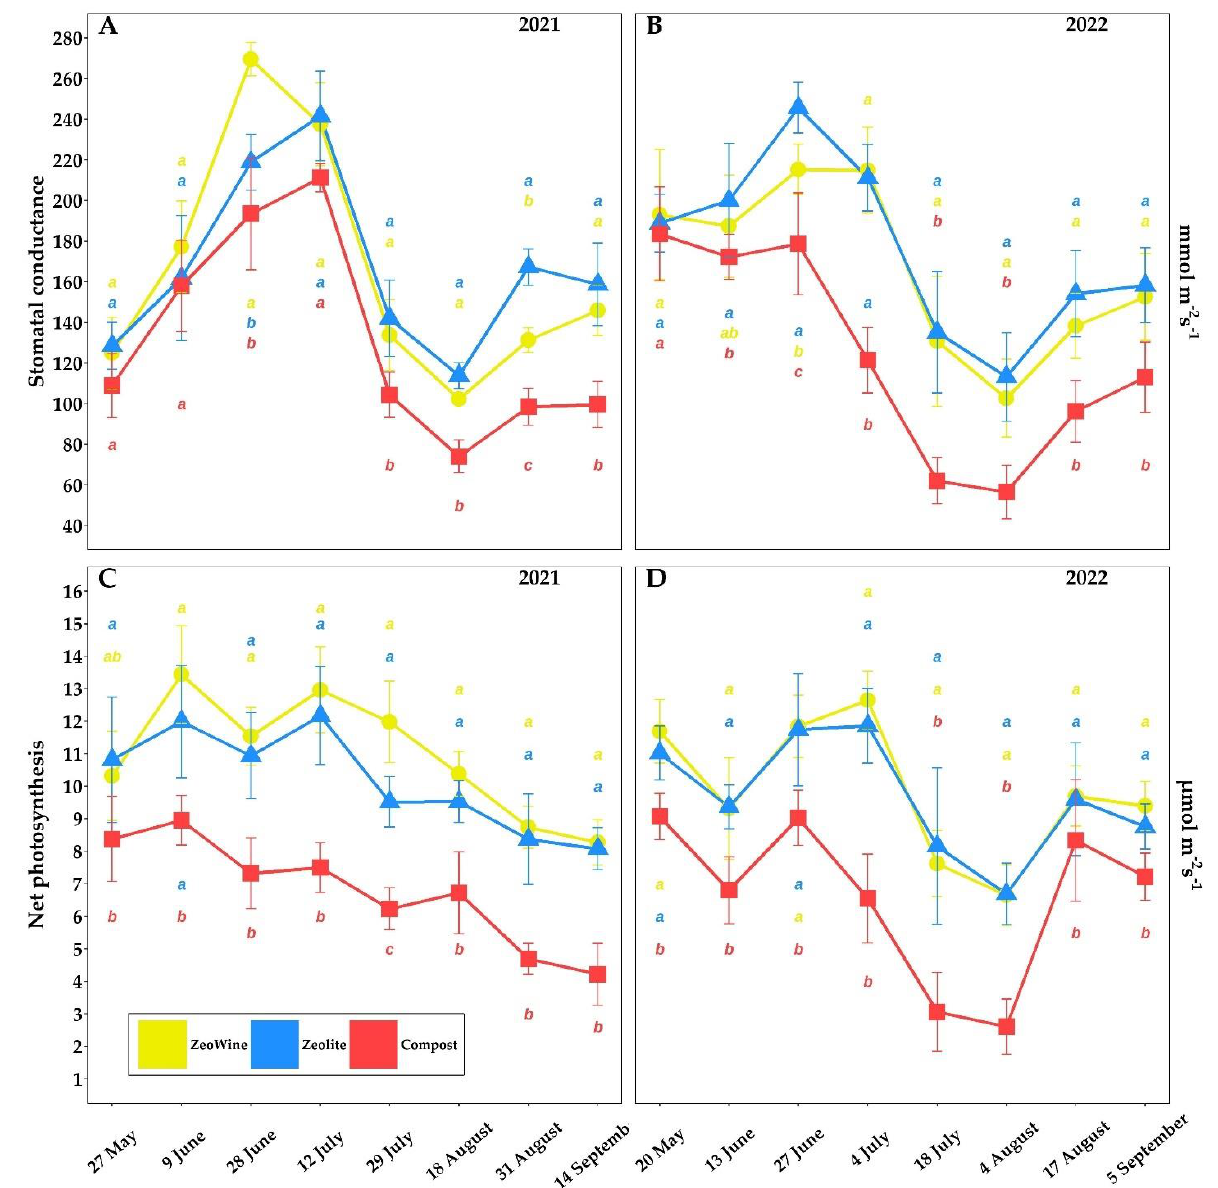
Figure 2. Physiological parameters (semel). Net photosynthesis (PN) and stomatal conductance (gs) of Vitis vinifera with three different soil management treatments. Measurements were conducted from May to September (2021 and 2022, ( A ) – ( D )). Data (mean ± SE, n = 10) were subjected to one-way ANOVA. The bars represent the standard deviation. Different letters indicate significant differences between Zeowine, Zeolite, and Compost (LSD test, p ≤ 0.05). Stomatal conductance and net photosynthesis follow the seasonal trend. Significant differences in net photosynthesis and stomatal conductance during the seasons were found. Generally, no differences were ever found between the Zeowine and the zeolite treatments. Observing the 2022 vintage in stomatal conductance, differences emerge as early as June. In both years, the compost recorded lower values in net photosynthesis in each measure of the season (2021 and 2022).